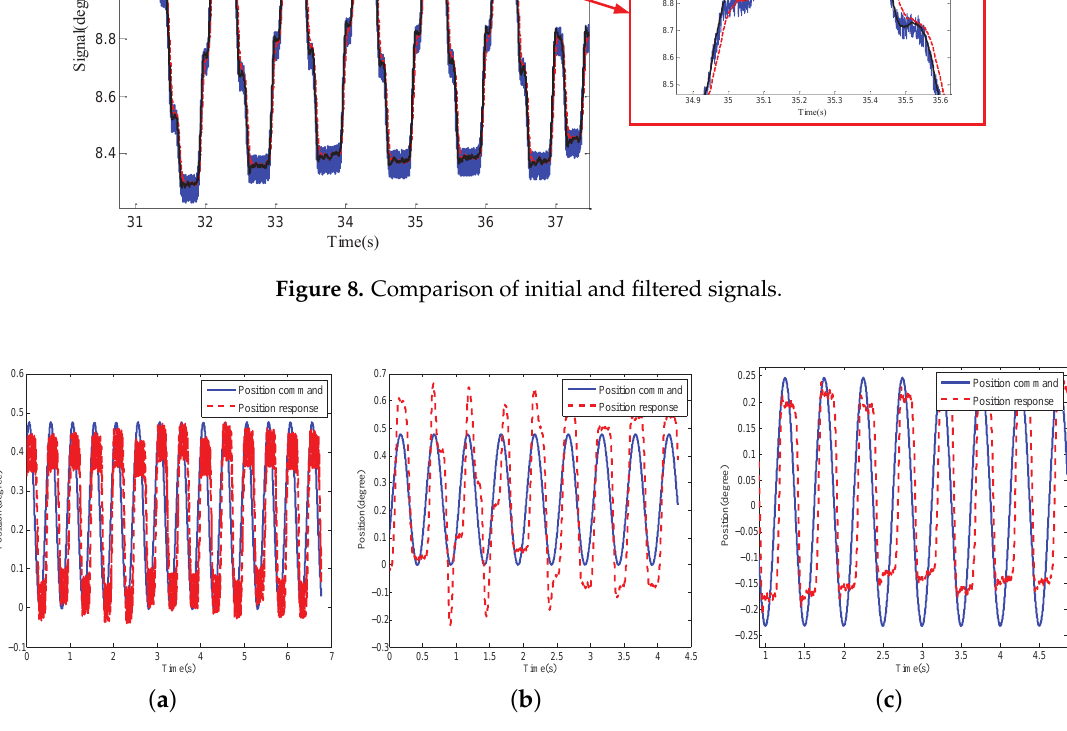
Figure 9. Closed loop performance comparison of initial and filtered signals: ( a ) With initial signal; ( b ) With traditional LPF singal ; ( c ) With phase lag-free LPF signal.